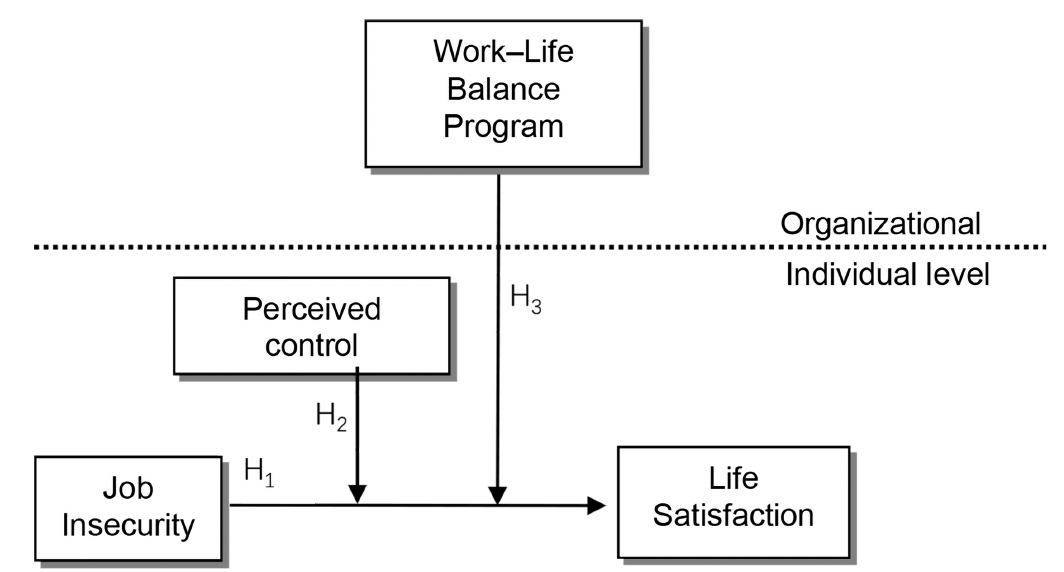
Fig. 1. The conceptual framework for this study.